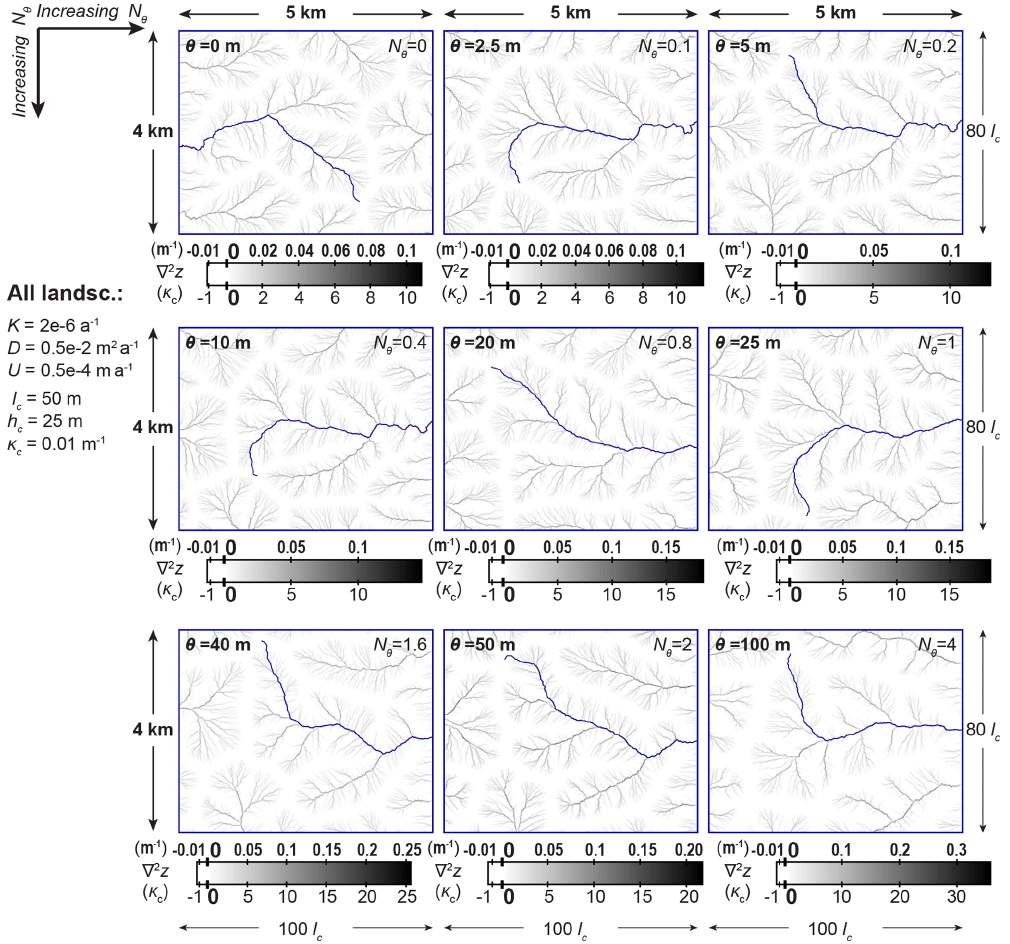
Figure 8. Deeper and sparser valleys and wider hillslopes, in landscapes with higher incision-threshold numbers N θ . Steady-state maps of the Laplacian curvature ∇ 2 z of the landscapes of Sect. 3.2 reveal how valley networks and hillslopes change as N θ increases. Areas with ∇ 2 z ≤ 0 are shown in white, and areas with ∇ 2 z > 0 are shown in grayscale. Gray dendritic patterns indicate valley networks, because concave areas can be considered as valleys, and convex areas can be considered as ridges or hillslopes (e.g., Howard, 1994). As N θ increases, ridges and hillslopes become wider, and gray dendritic valley patterns become sparser. The color scales of the nine maps are not the same; as N θ increases, the maximum value of curvature increases, and, thus, curvature has a wider range of positive values. Therefore, as N θ increases, concave areas become more concave, i.e., valleys become deeper. By contrast, the minimum value of curvature is ∇ 2 z = − κ c in all color scales, and, thus, the most convex areas are equally convex in all maps. However, the extent of these most convex areas becomes wider as N θ increases, because the value ∇ 2 z = − κ c corresponds to zones of zero incision (see Sect. 2.2), which become wider as N θ increases (see Fig. 7). Therefore, as N θ increases, hillslopes become more convex because bigger portions of them have the minimum value of